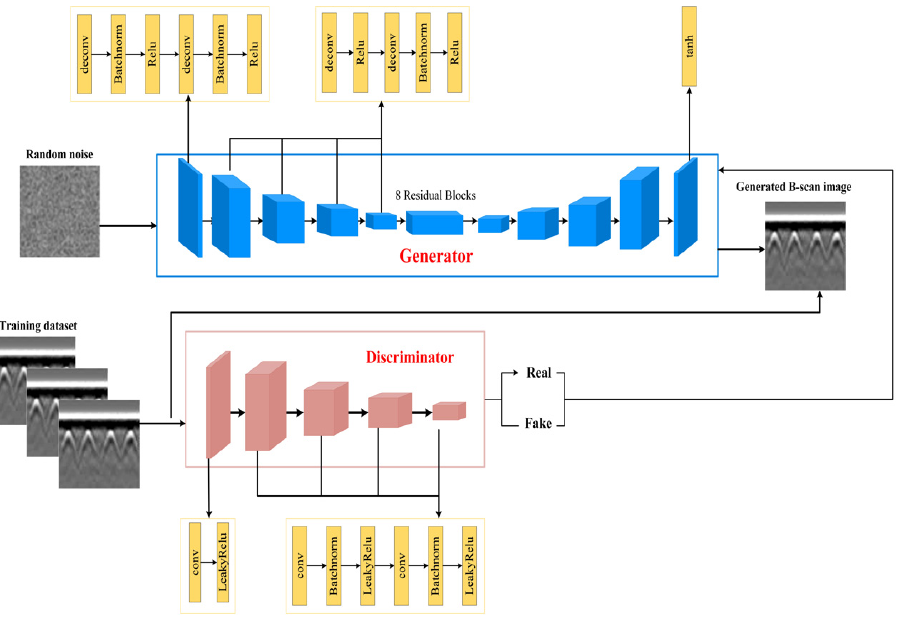
Figure 2. Architecture of the improved LSGAN.